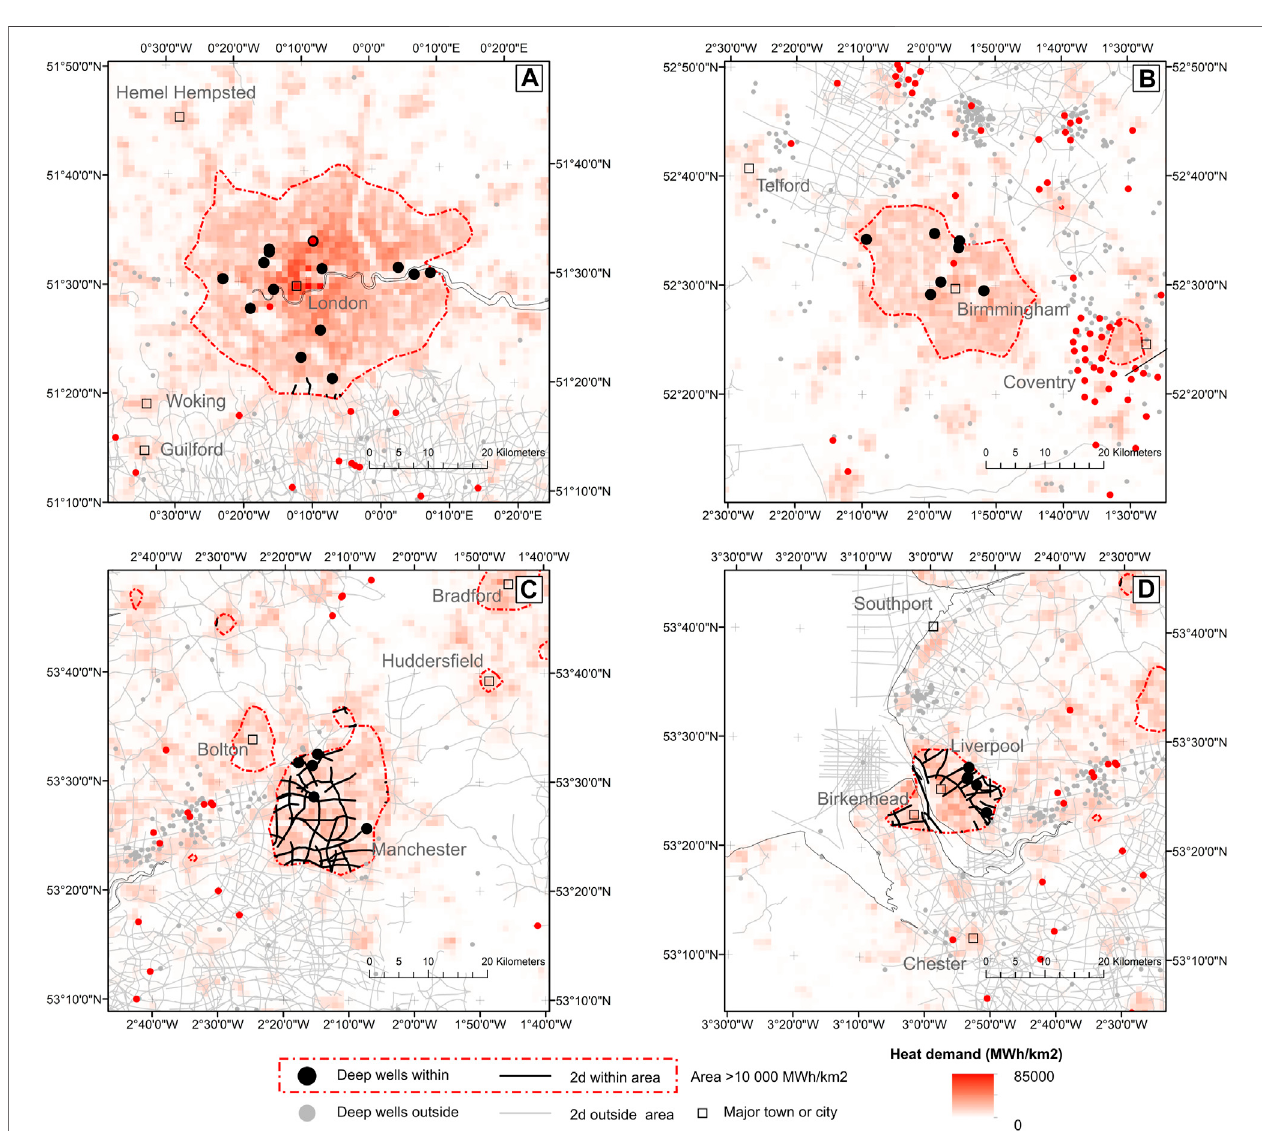
FIGURE 7 | Subsurface data coverage, showing the location of both 2D seismic data and the deep boreholes from UKOGL in relation to heat demand across (A) London, (B) Birmingham, (C) Manchester and (D) Liverpool.